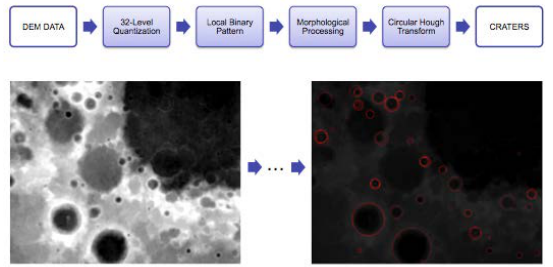
Figure 3. - Crater extraction procedure scheme developed by University of